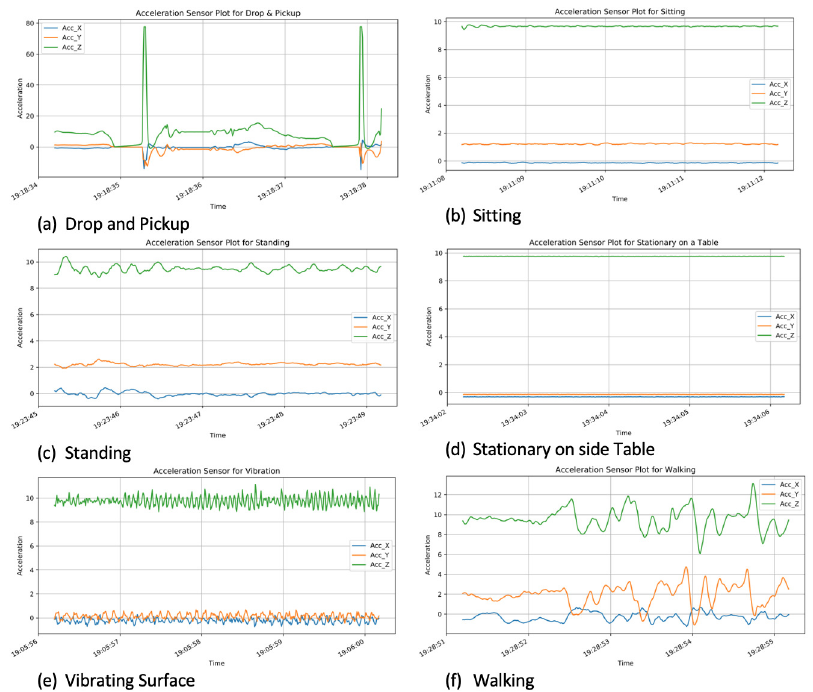
Figure 3. Acceleration signals for the six activities.